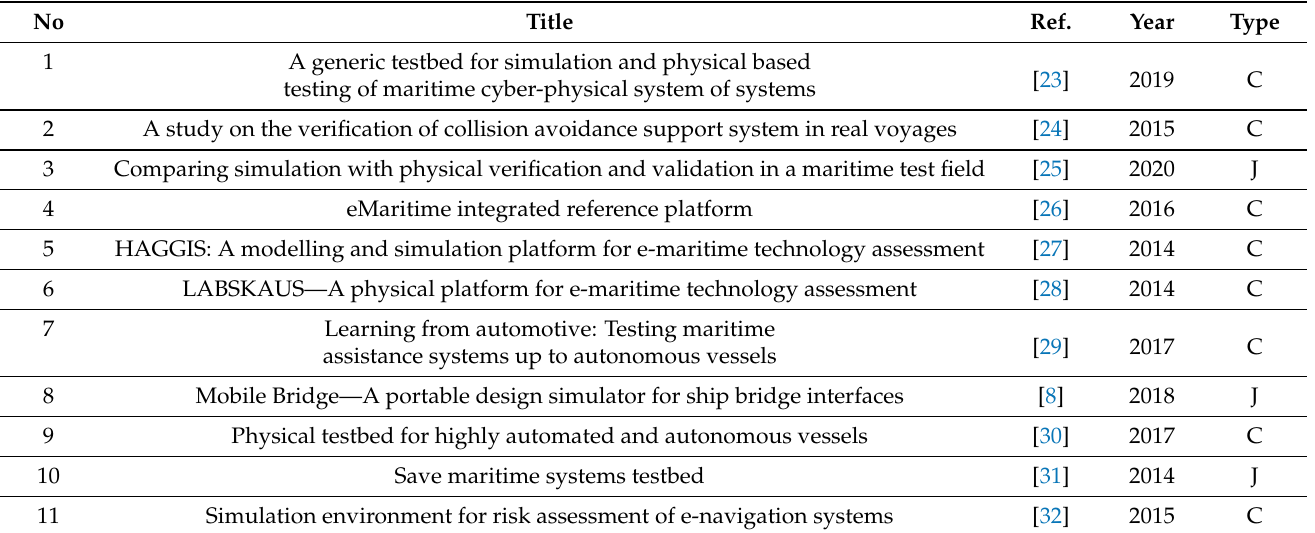
Table 1. The final result of the